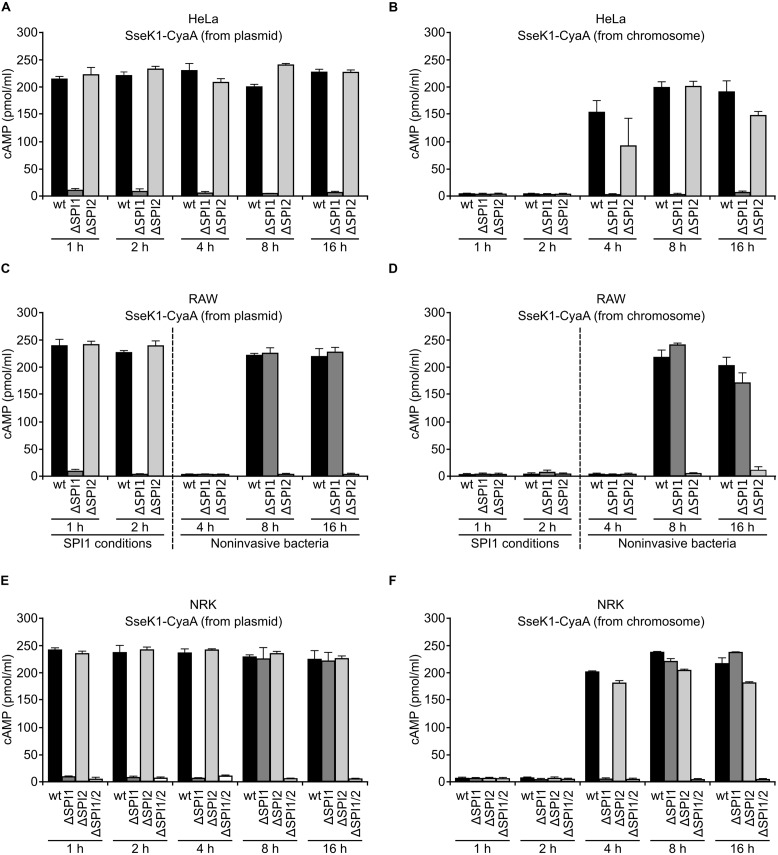
Translocation of SseK1 into mammalian cells. Human epithelial HeLa cells (A,B), RAW264.7 murine macrophage-like cells (C,D) and NRK-49F normal rat kidney fibroblasts (E,F) were infected with derivatives of S. enterica serovar Typhimurium 14028 (wild-type, wt, ΔSPI1, ΔSPI2 and ΔSPI1 ΔSPI2 strains) carrying a plasmid expressing an SseK1-CyaA’ fusion from a constitutive promoter (A,C,E) or a chromosomal SseK1-CyaA’ fusion expressed under the native sseK1 promoter (B,D,F). Bacteria were grown under SPI1-inducing conditions for most infections. Non-invasive bacteria were used specifically for infections of RAW264.7 cells for 4, 8, and 16 h. To detect translocation, the level of cAMP was measured 1, 2, 4, 8, and 16 h p.i. Means and SD from triplicate experiments are represented.